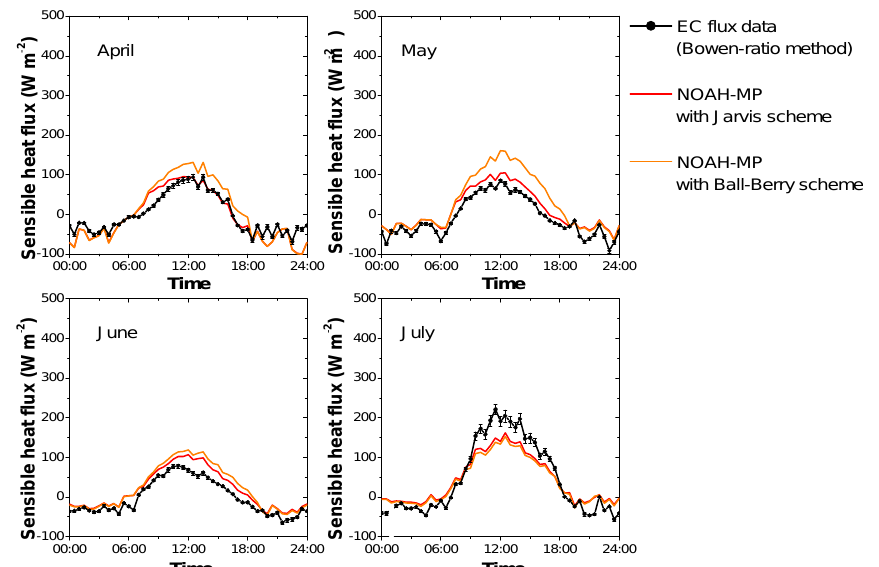
Figure 6. State-of-the art approach to compare simulated and measured eddy covariance flux data. The monthly average cycles of sensible heat flux were computed based on Bowen ratio post-closed data. For modelling, the NOAH-MP land surface model was used in two con- figurations. The stomatal resistance was computed either with the empirical Jarvis scheme or the photosynthesis-based Ball–Berry scheme. The simulated fluxes are compared with measured eddy covariance (EC) flux data that were adjusted with the Bowen ratio method. The error bars indicate the random measurement error. In some cases, the error bars are smaller than the size of the symbol and therefore not